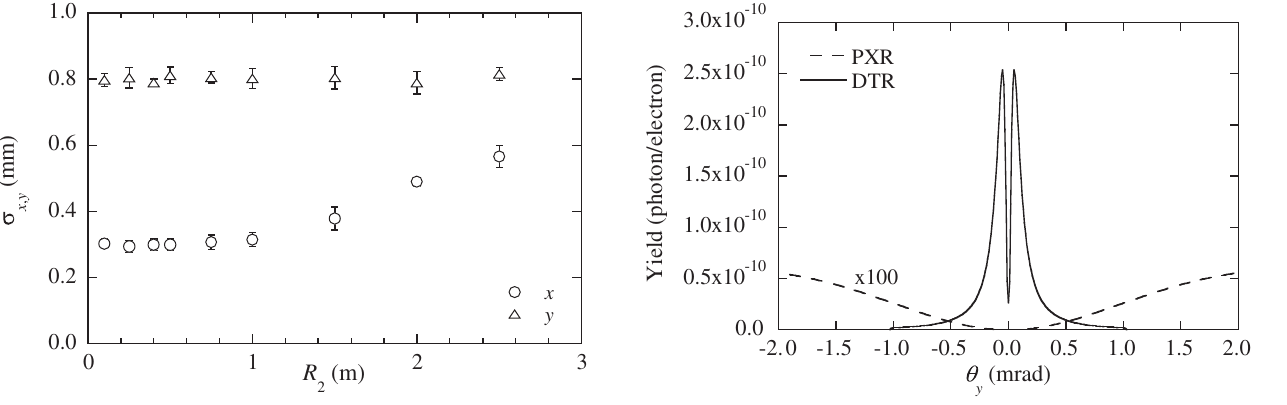
FIG. 5. Vertical angular distribution of radiation for reflection (022) from a silicon crystal, electron energy 10 GeV, and observation angle Θ D ¼ 32 . 2